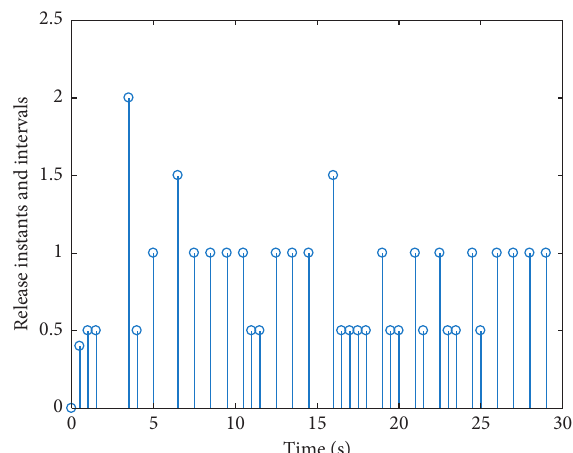
Figure 15: The “event-triggered” of “hybrid-driven” release in- stants and interval of Example 2.